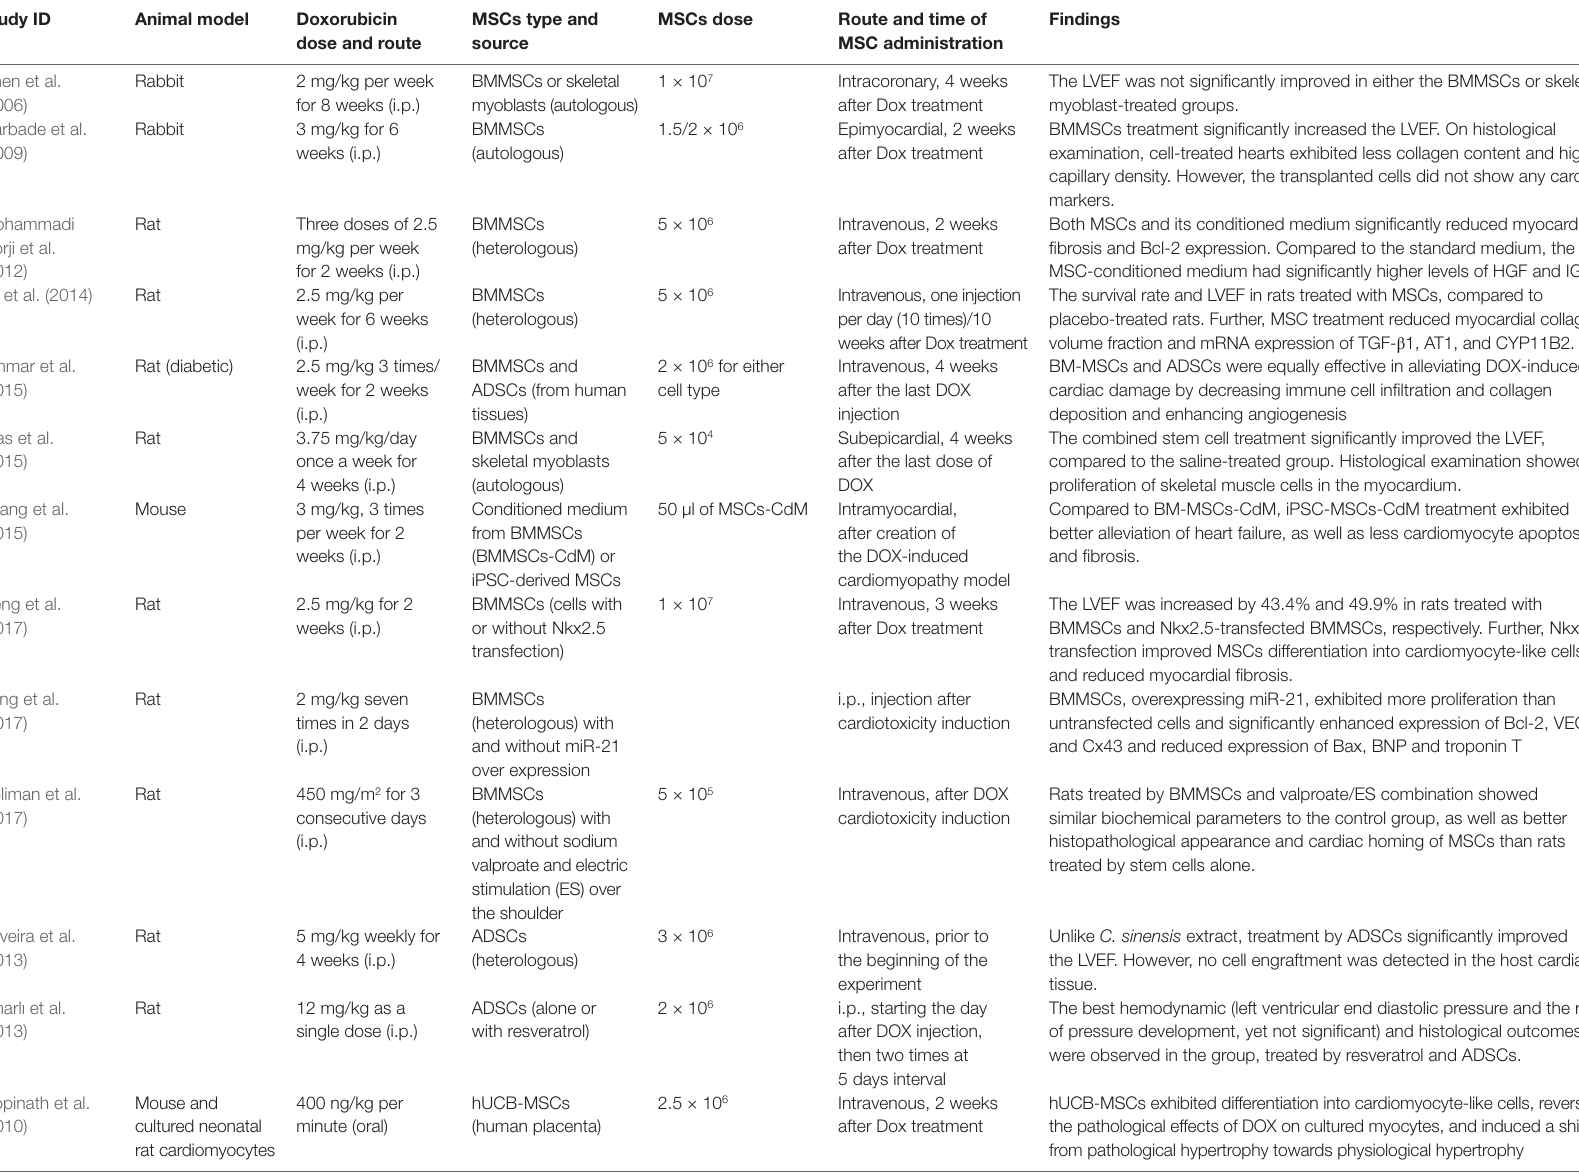
TABLE 1 | Summary of the methods and experimental findings on using mesenchymal stem cell therapy for DOX-induced cardiotoxicity. Study ID